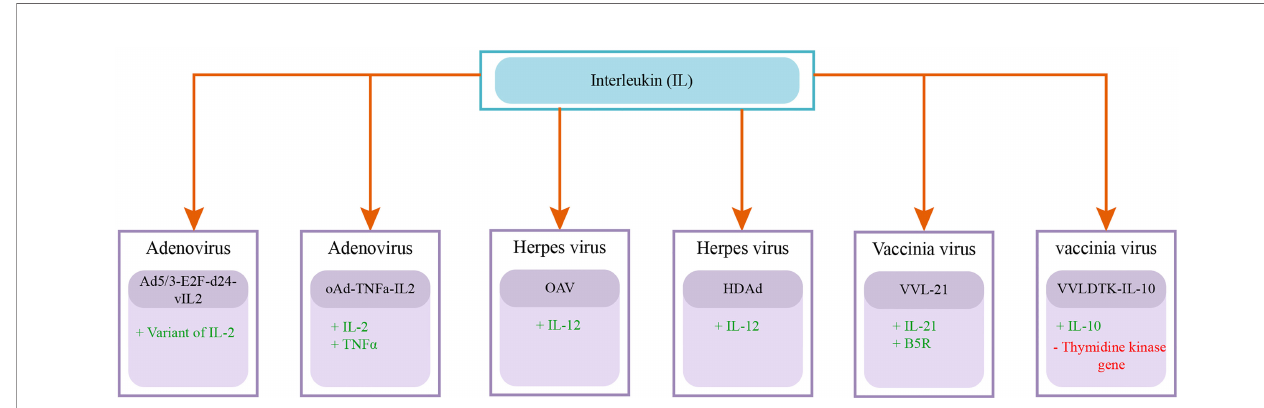
FIGURE 4 | Recombinant Oncolytic Viruses armed with Interleukin (IL) genes: Interleukins function as a mode of communication between immune and non-immune cells. They play a crucial role in both innate and adaptive immune responses. These proteins also regulate cancer development by concurrently promoting cancer cell progression and evoking tumor targeted immune activity. Based on these properties, interleukins could be utilized in immunotherapy for impeding adverse effects and improved ef fi cacy (245). Ad5/3- E2F-d24-vIL2 is a genetically altered adenovirus that expresses a variant of IL-2 for prolonged survival and eliciting immune response (135). Another recombinant adenovirus, oAd-TNFa-IL2, is speci fi cally designed to express TNF- a and IL-2. The treatment of oAd-TNFa-IL2 combined with meso-CAR T cells resulted in curbed metastasis and improved immune activity in mouse models (139). Oncolytic viruses are genetically modi fi ed to express an antitumor cytokine, Interleukin 12. IL-12 expression aids in restricting tumor angiogenesis, in the differentiation of T-helper cells, which eventually promotes T cells directed cancer cell destruction (246). Oncolytic herpes simplex viruses are genetically modi fi ed by inserting IL-12 exogenous gene to generate OAV and HDAd. The administration of OAV caused high toxicity associated with overexpression of IL-12 in cancer cells, and treatment with HDAd resulted in comparatively slow release of IL-12 from the liver, which eventually caused restricted tumor growth (150). VVL-21 is a recombinant vaccinia virus, particularly designed to treat pancreatic cancer by incorporating B5R and IL-21 genes. The administration of VVL-21 combined with ( a -PD1) triggered immune activity opposed to cancer cells (191). VVLDTK-IL- 10, another recombinant vaccinia virus, is designed by omitting TK gene and inserting IL-10 exogenous gene for promoting antitumor response and prolonged survival (200). Interleukin (IL) gene along with other added genes written in green with + sign and deleted genes written in red with -